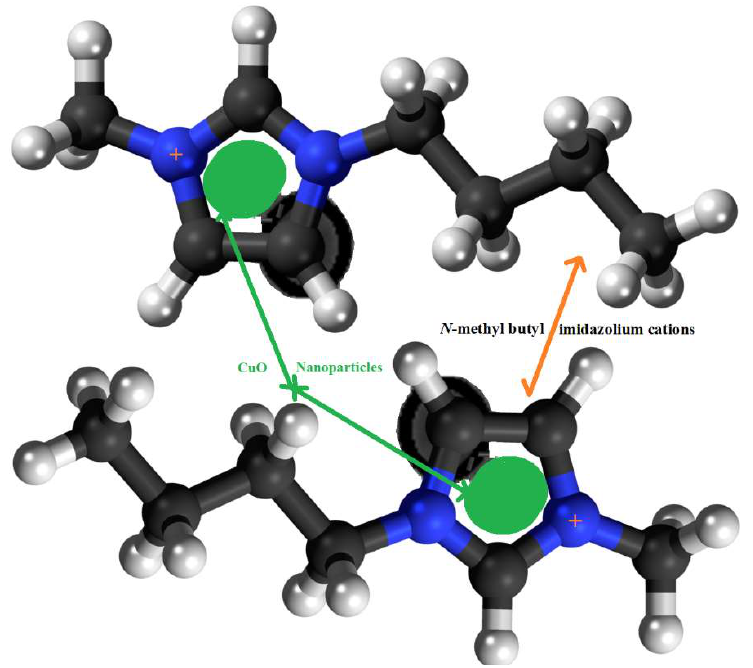
Figure 3. The structure of N-methyl butyl imidazolium cation copper oxide nanocomposite.